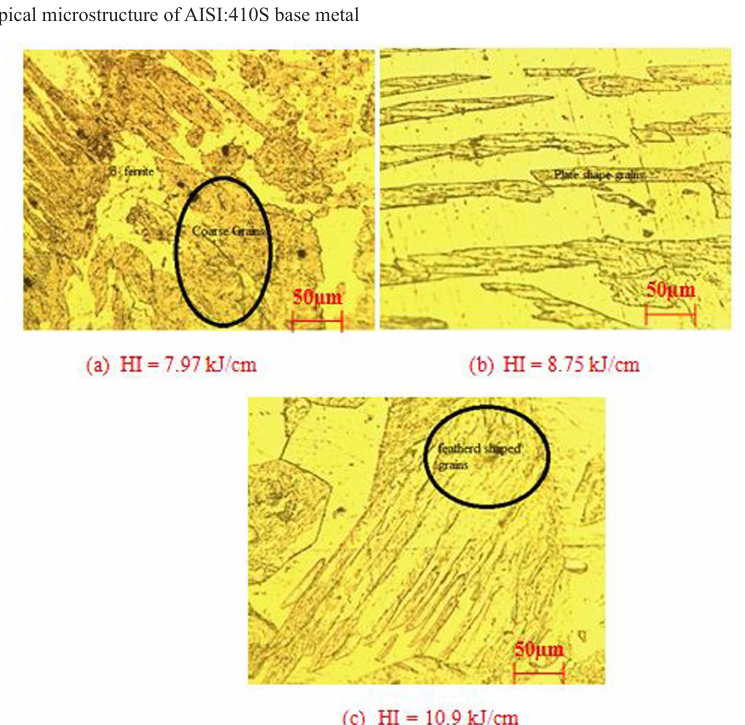
Figure 3. (a-c) The microstructure of GTA weld deposits under different heat